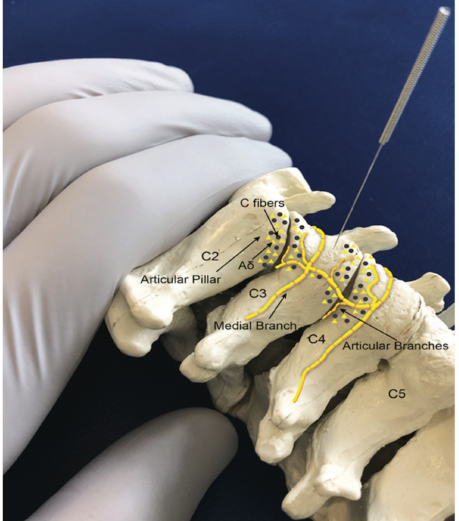
Figure 3. Description of PDN technique and potential mechanisms. (A) The patient was positioned in side-lying to expose the lateral neck in a neutral position. (B) Palpation began at the mastoid process of the temporal bone and progressed to the prominent transverse process of C1. Next, the articular processes of C2 and C3 were palpated by moving posterior and caudal along the neck. (C) Then, the overlying muscles were compressed and held down toward the articular pillars to feel bone, and the needle was inserted at a 60 degree anteromedial orientation towards an area of discrete hardness felt under the palpating hand. (D) PDN was applied to the dorsolateral region of the C2–C3 articular pillars using insertion of needles at 8–10 mm depth until reaching bone, followed by 6 taps onto each pillar within a 3–4 mm area using 0.25 × 30 mm Agupunt APS Regular Dry Needles. (E) Needling induces analgesia by distortion of the periosteum on the CAP activating A δ and C-fiber afferents, and if contacted can exert high-pressure stimuli to the medial branches of the dorsal rami, as well as nearby facet joint nociceptors. Abbreviations: PDN, periosteal dry needling; CAP, cervical articular